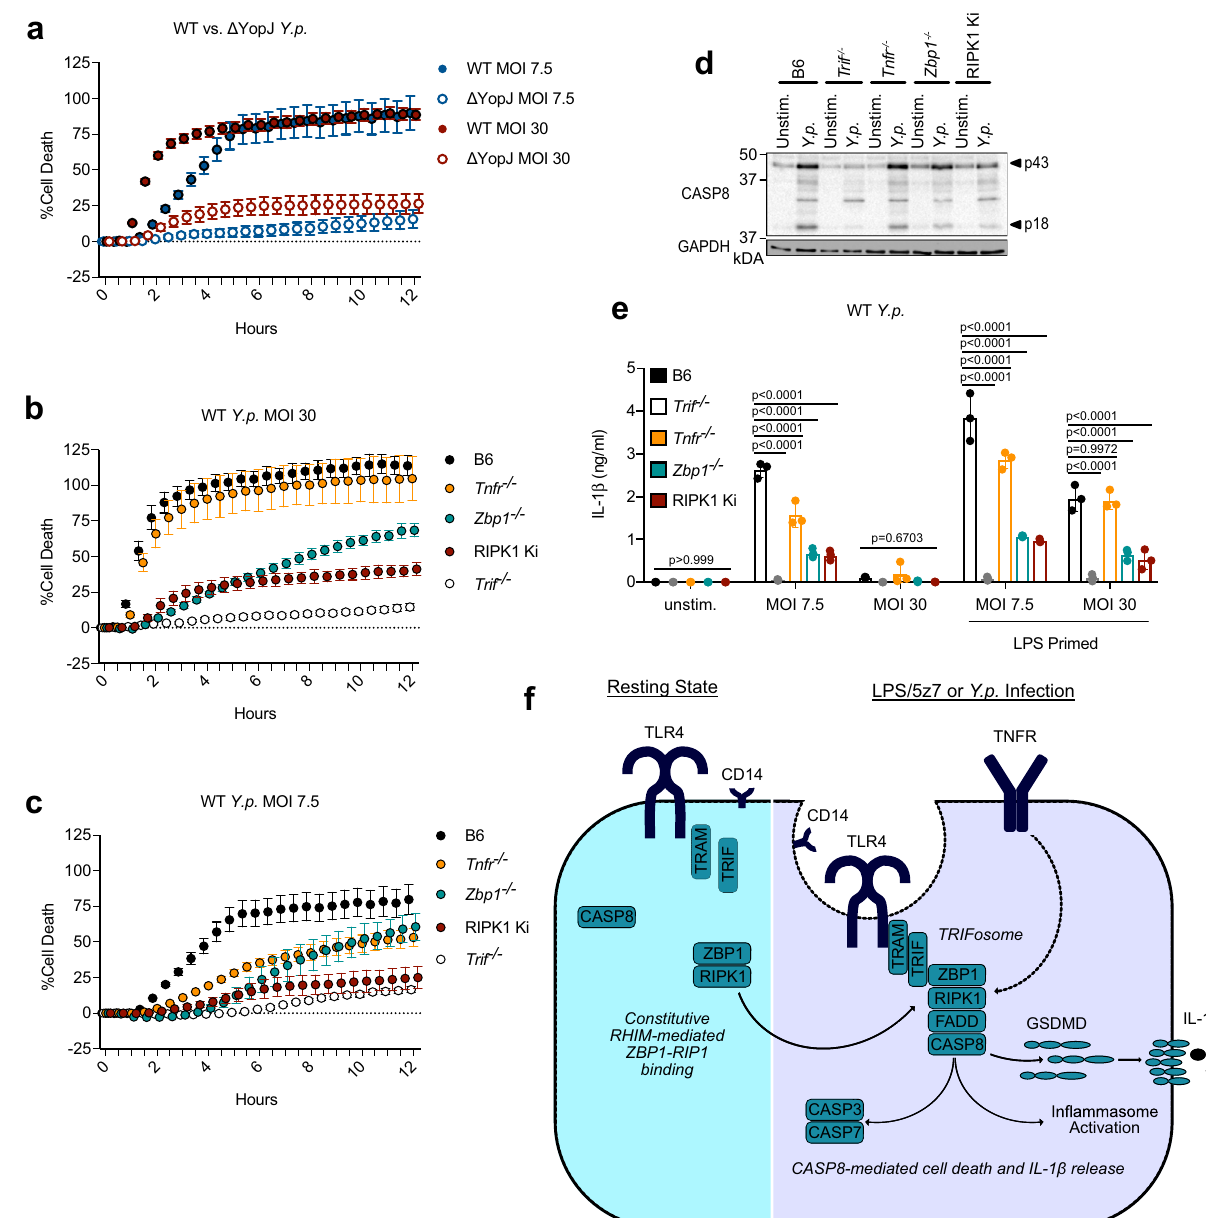
Fig. 6 The TRIFosome regulates cell death in response to Yersinia . a Cell death as measured by propidium iodide (PI) incorporation in B6 BMDMs infected with wild-type or YopJ-de fi cient ( Δ YopJ) Y. pseudotuberculosis at indicated MOI. b , c Cell death as measured by PI incorporation in indicated BMDMs infected with wild-type Y. pseudotuberculosis at b 30 MOI or c 7.5 MOI. d CASP8 cleavage in indicated BMDMs infected with wild-type Y. pseudotuberculosis at 30 MOI for 2 h. e IL-1 β release after 6 h of wild-type Y. pseudotuberculosis infection at 7.5 or 30 MOI in indicated BMDMs that were primed or unprimed with LPS for 4 h prior to infection. f Model of ZBP1-regulated TRIFosome formation leading to CASP8-mediated pyroptosis and IL-1 β release. Data from cell death assays and western blots are representative of 3 or more biologically independent experiments, cell death data are presented as the mean ± SD of triplicate wells, n = 10,000 cells examined in three individual wells. IL-1 β release data are presented as the mean ± SD for triplicate wells from n = 3 biologically independent experiments. Two-way analysis of variance (ANOVA) was used for comparison between groups. Source data for all experiments are provided as a Source data fi